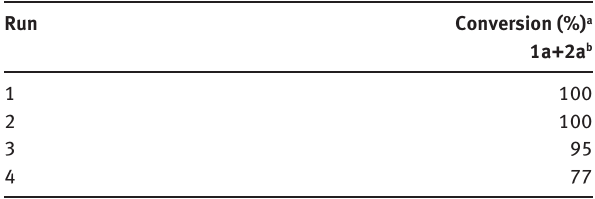
Table 2: Recyclability of Pd/G in Suzuki-Miyaura